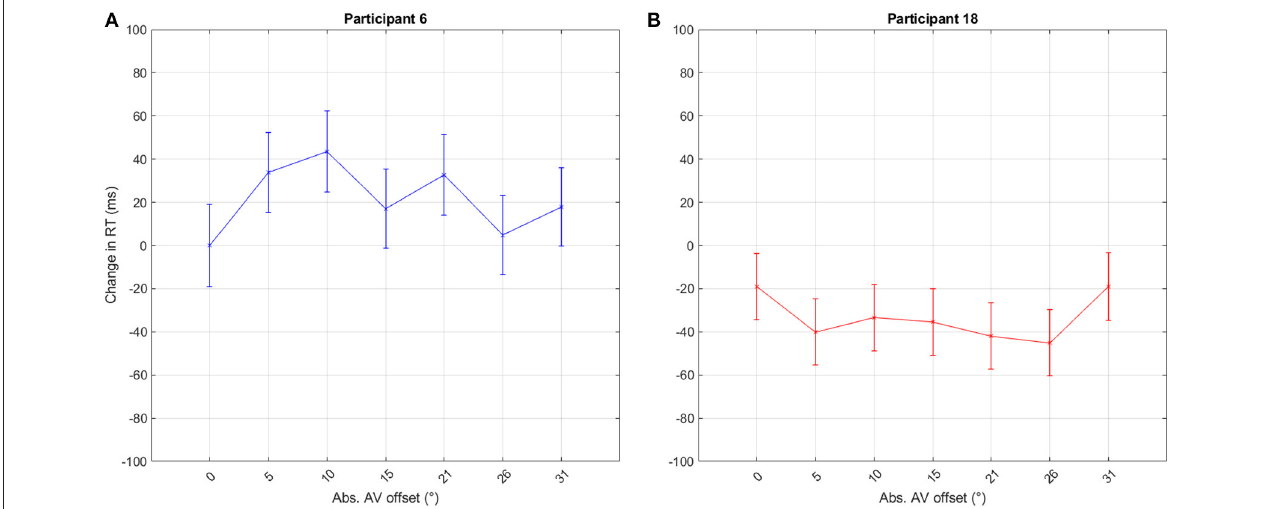
FIGURE 6 | RT distribution of two participants from the first experiment when pooled across left and right offsets. The graphs show the estimated difference in RT from the mean RT at 0 ◦ . The bars indicate the standard error. These two datasets exemplify the huge differences between participants and also show both typical co-activation model (A) and Colavita effect (B) at offsets. The y-axis indicates the difference in RT between responses given with no offset, 0 ◦ , and those with